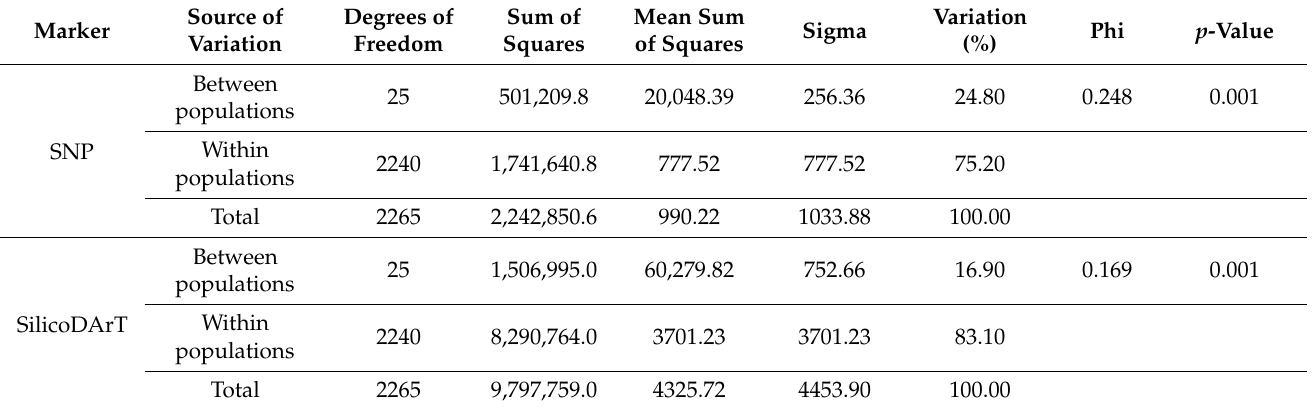
Table 4. AMOVA result for the populations according to the accessions’ countries of